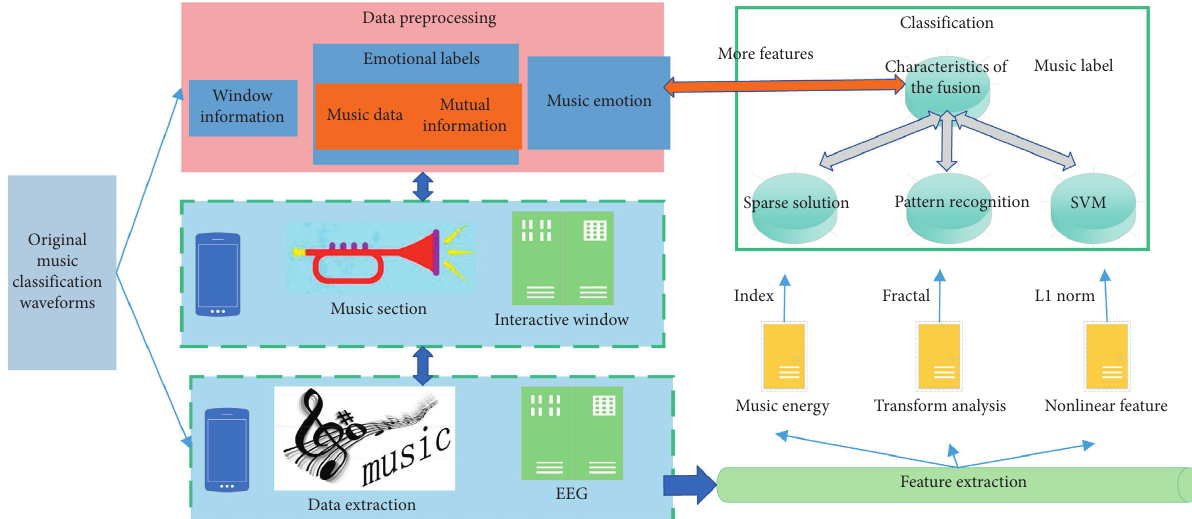
Figure 1: Music classification and recognition framework with multifeature fusion.